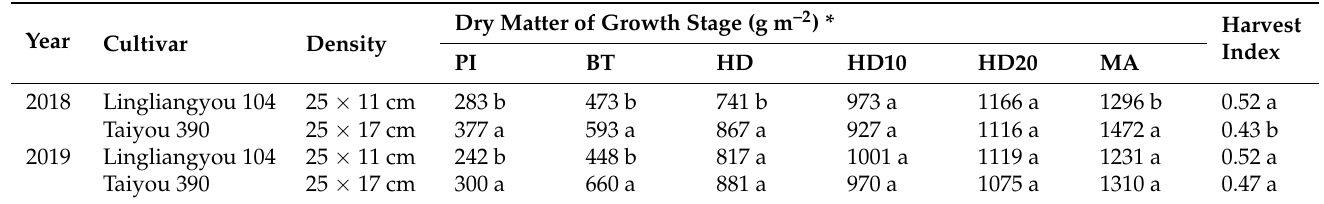
Table 3. Aboveground biomass accumulation and harvest index of two growth duration rice cultivars under two planting densities in 2018 and 2019.